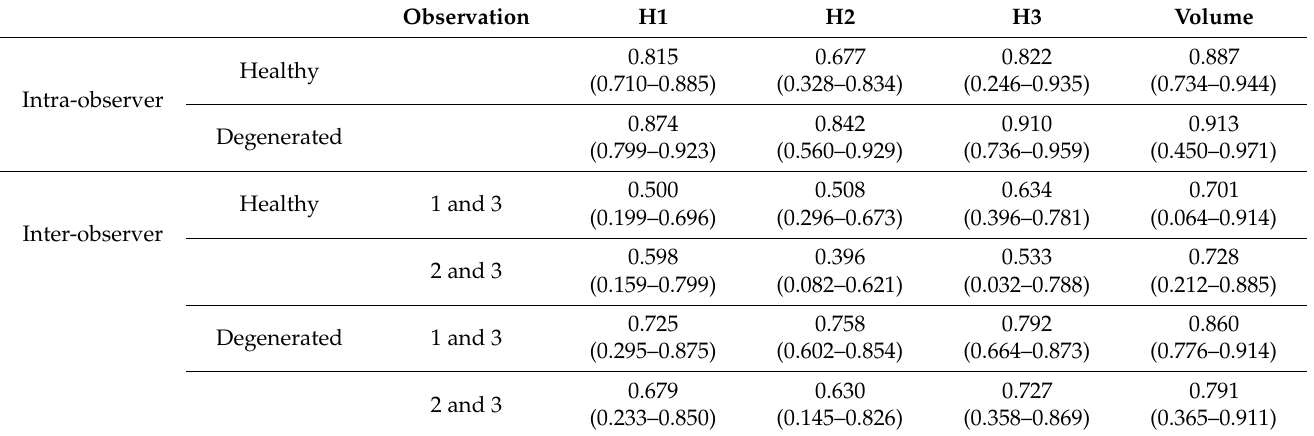
Table 2. Inter- and intra-observer reliability of the methods for the measurement of disc height by three different methods (H1, H2 and H3) and the volume of healthy and degenerated lumbar discs. ICC values are given as mean, and in brackets, the lower and upper limits of the 95% confidence interval. Observation H1 H2 H3